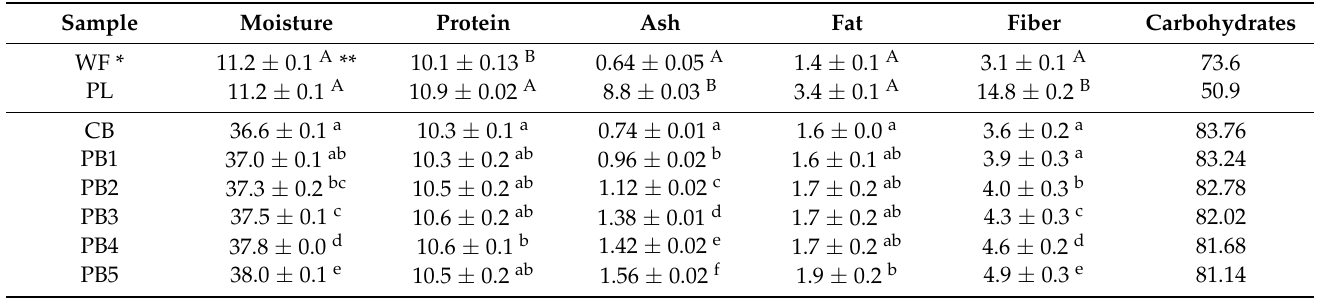
Table 1. Basic chemical composition of wheat flour, PL, and bread. The basic chemical compounds of bread (protein, ash, fat, fiber, and carbohydrates) were expressed as a percentage of dry weight basis. Moisture Protein